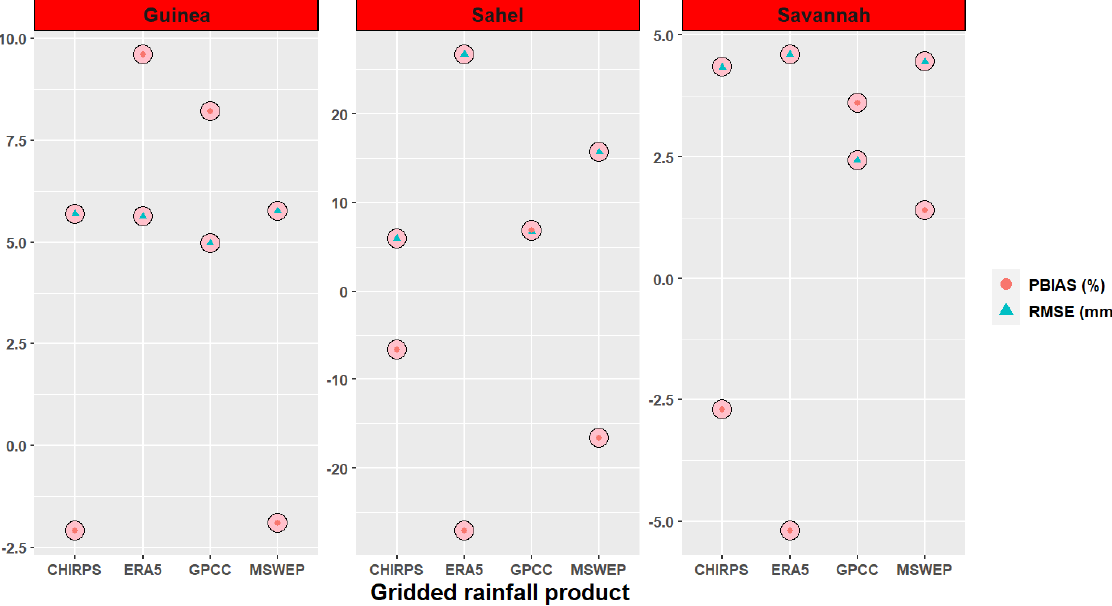
Figure 7. Error Indices for rainfall products.